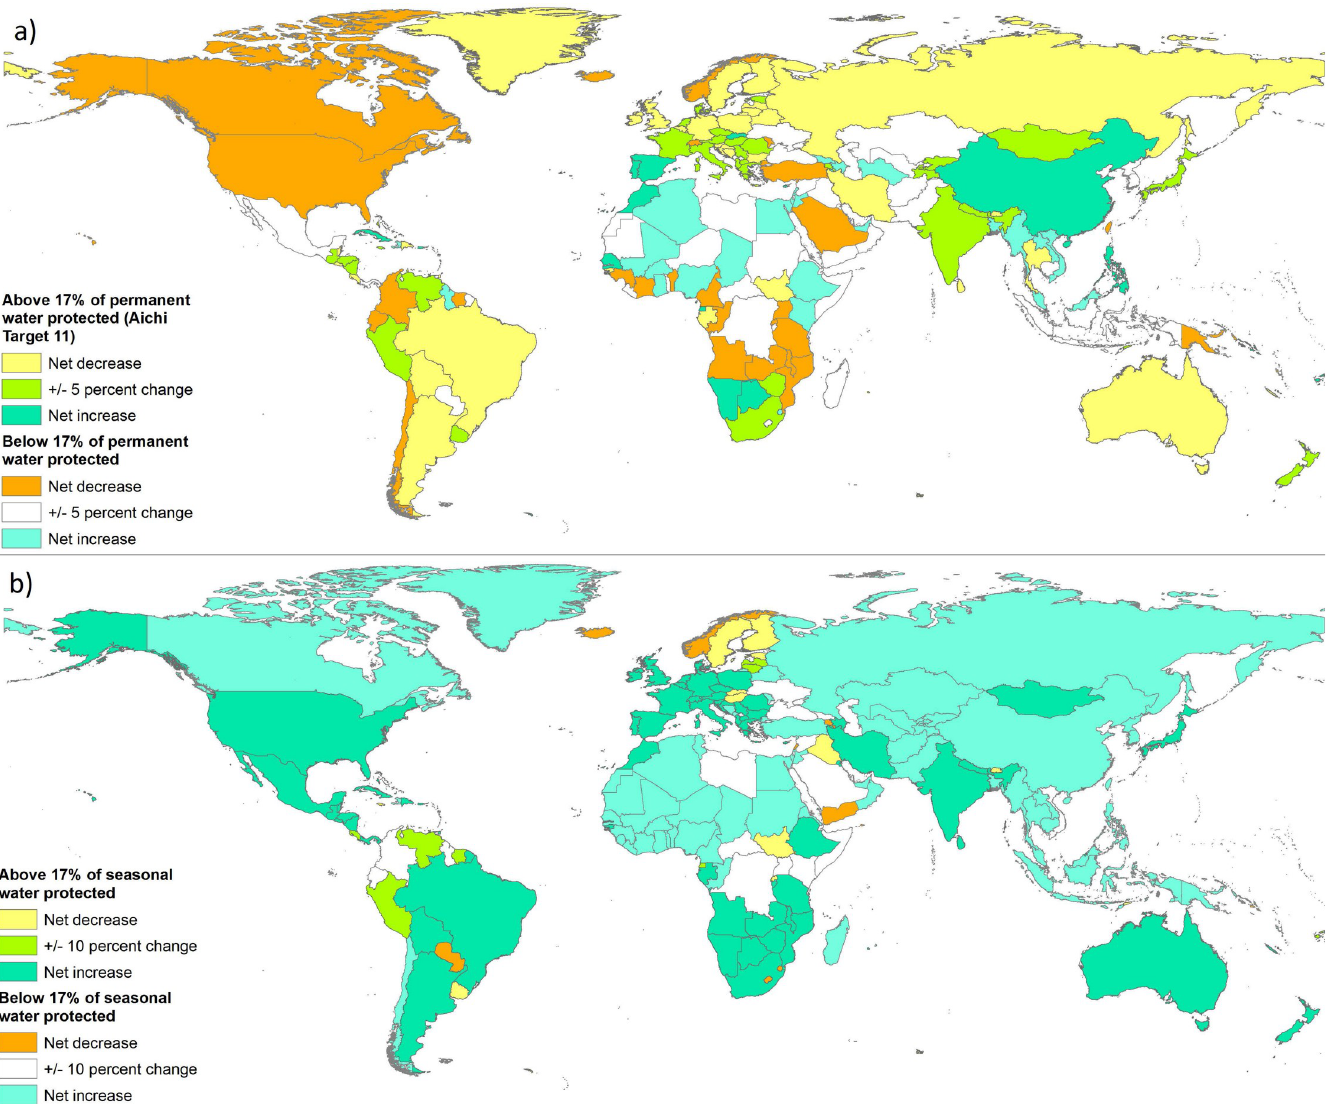
Fig 3. Water trends within protected areas, 1984–2015. Surface water trends (increasing or decreasing in the period 1984–2015) within current PAs and surface water coverage by current PAs (above or below the 17% coverage specified in Aichi Target 11) separately assessed for permanent water (a) and seasonal water (b) in all countries. ‘Stable’ thresholds are +/- 5% for permanent water, and +/- 10% for seasonal / all